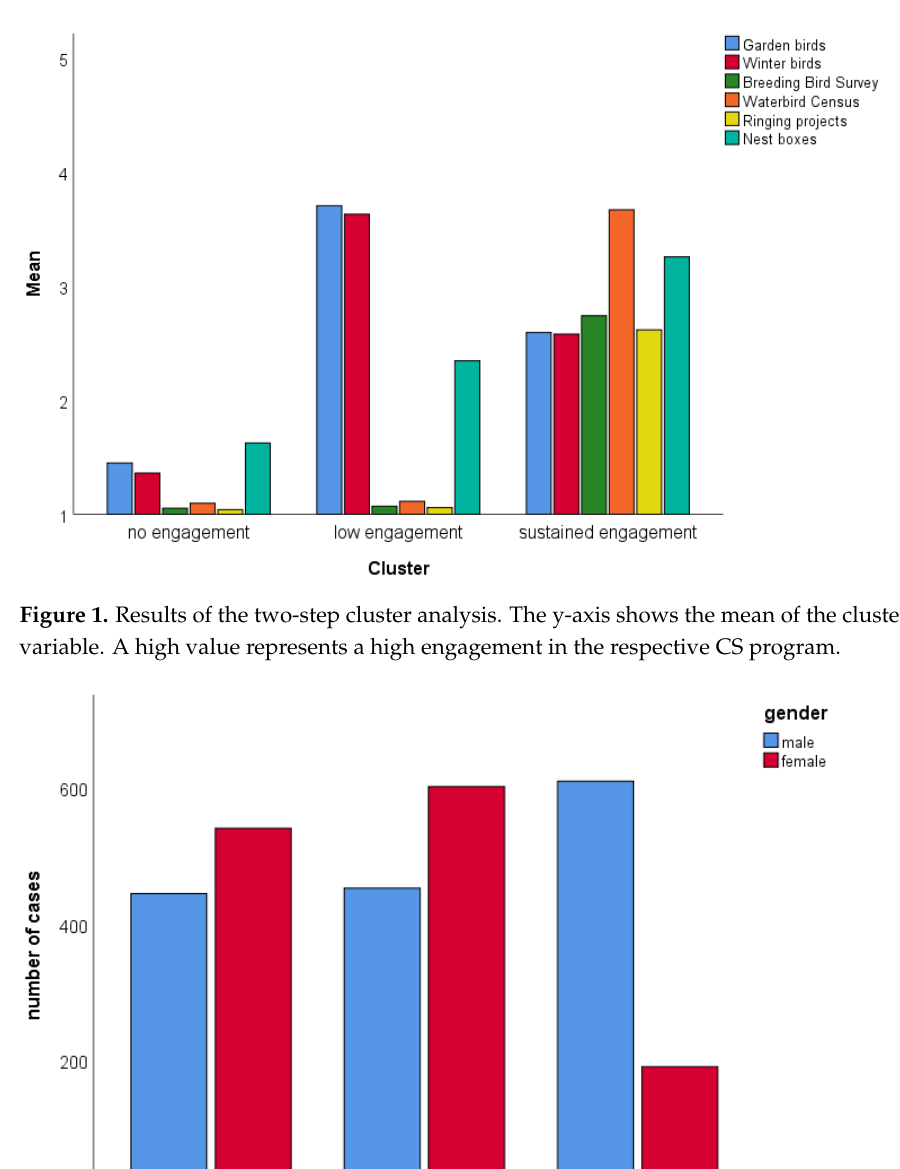
Figure 1. Results of the two-step cluster analysis. The y-axis shows the mean of the cluster for every variable. A high value represents a high engagement in the respective CS program.